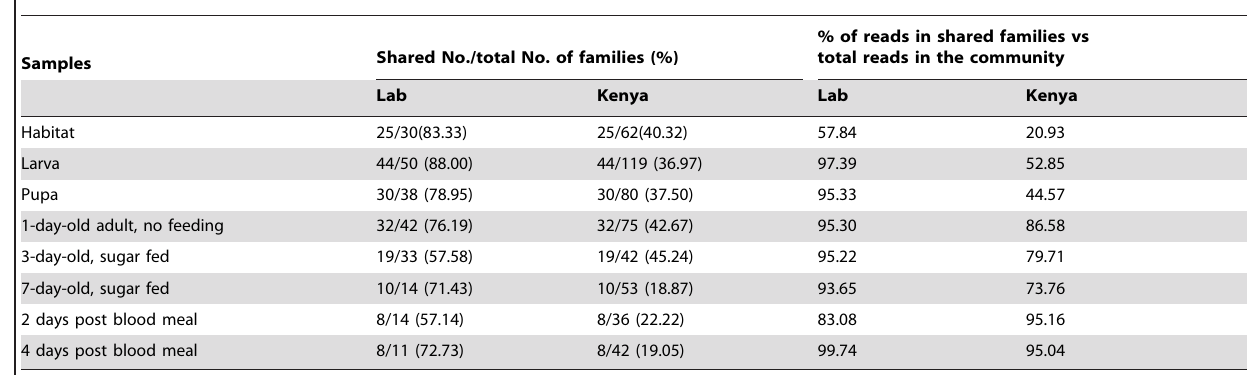
Refer Table S9 for composition details. doi:10.1371/journal.pone.0024767.t001 PLoS ONE |